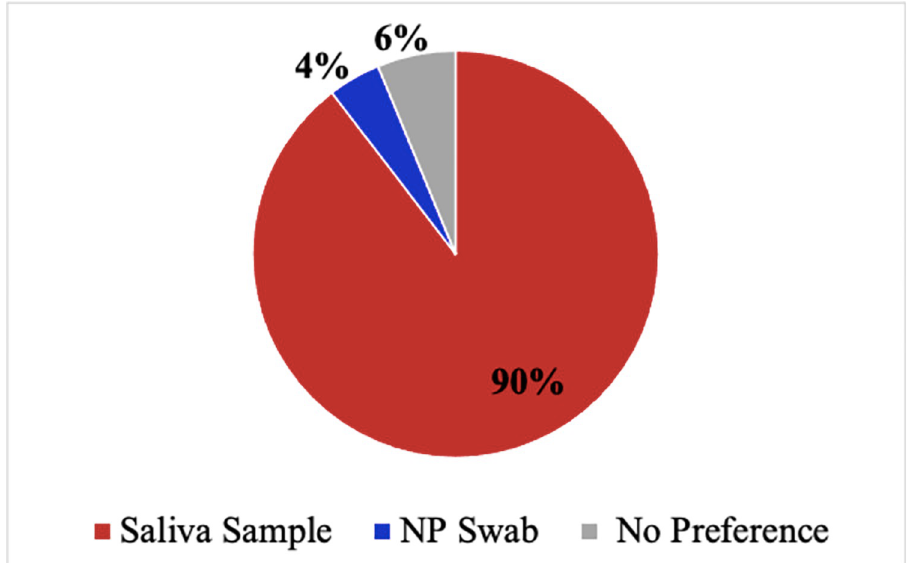
Fig 3. Preferred test in case of future need for testing (percent of